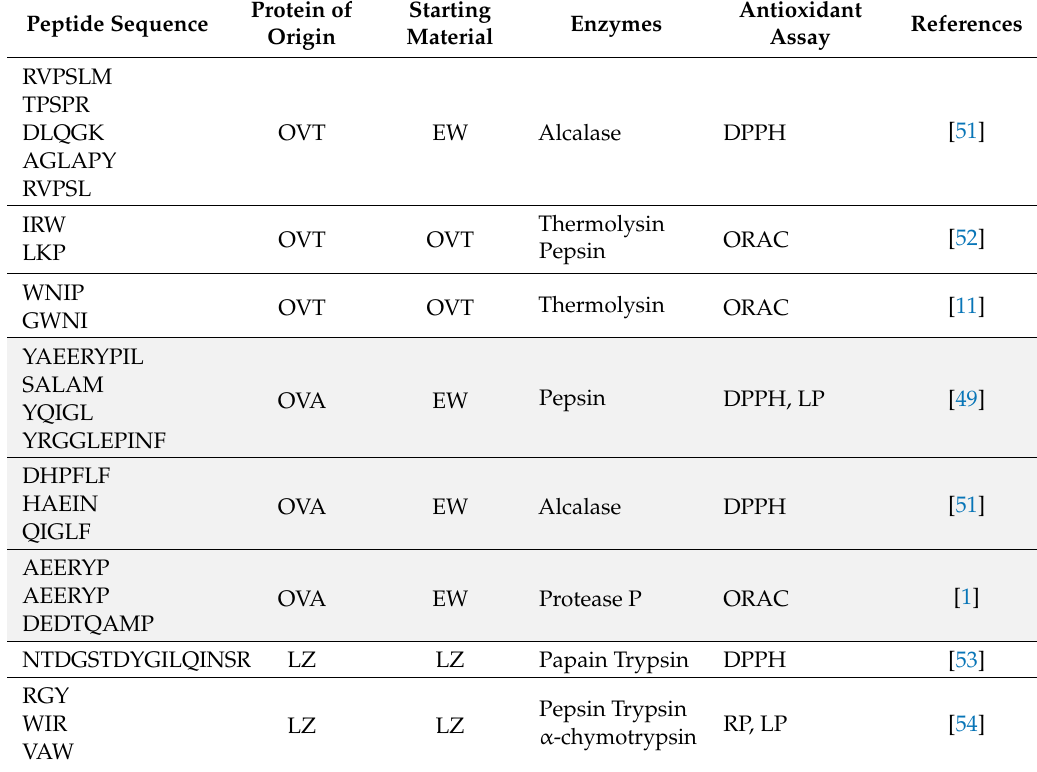
Table 1. Sequences of antioxidant peptides obtained by hydrolysis of chicken egg white proteins. Protein of Peptide Sequence Origin